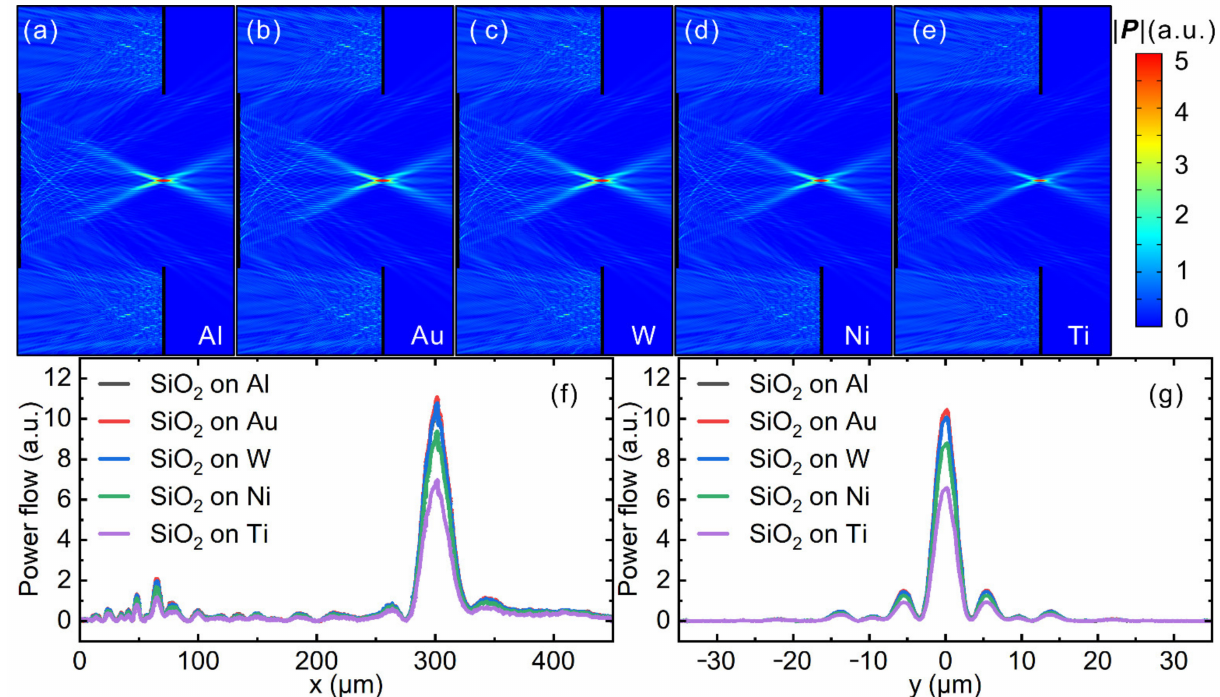
Figure 4. Optical performance of metasurface Cassegrain telescopes with metal constituents of ( a ) Al, ( b ) Au, ( c ) W, ( d ) Ti and ( e ) Ni, respectively, while all other parameters are the same as those discussed in the main text. Also shown are line-cut plots of the energy flux at the focus along ( f ) x- and ( g ) y-direction,